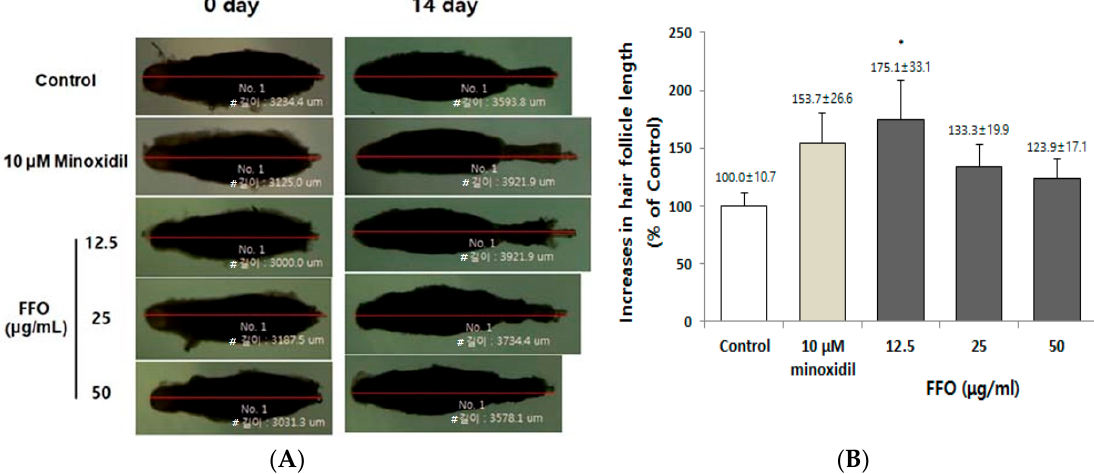
Figure 1. FFO extract increased the length of vibrissa follicles ex vivo. The rat vibrissa follicles were cultured with the indicated concentrations of FFO extract or minoxidil, a positive control, for 14 days. ( A ) Photographs of the length of the vibrissa follicles being cultured on Days 0 and 14. ( B ) Change in length of vibrissa follicles cultured in the presence of FFO extract or minoxidil for 14 days after isolation. The bar chart shows the percentage compared to the mean length of vehicle-treated control follicles at 14 days. Data are presented as mean ± SE. * p < 0.05 compared with the control. # means length.